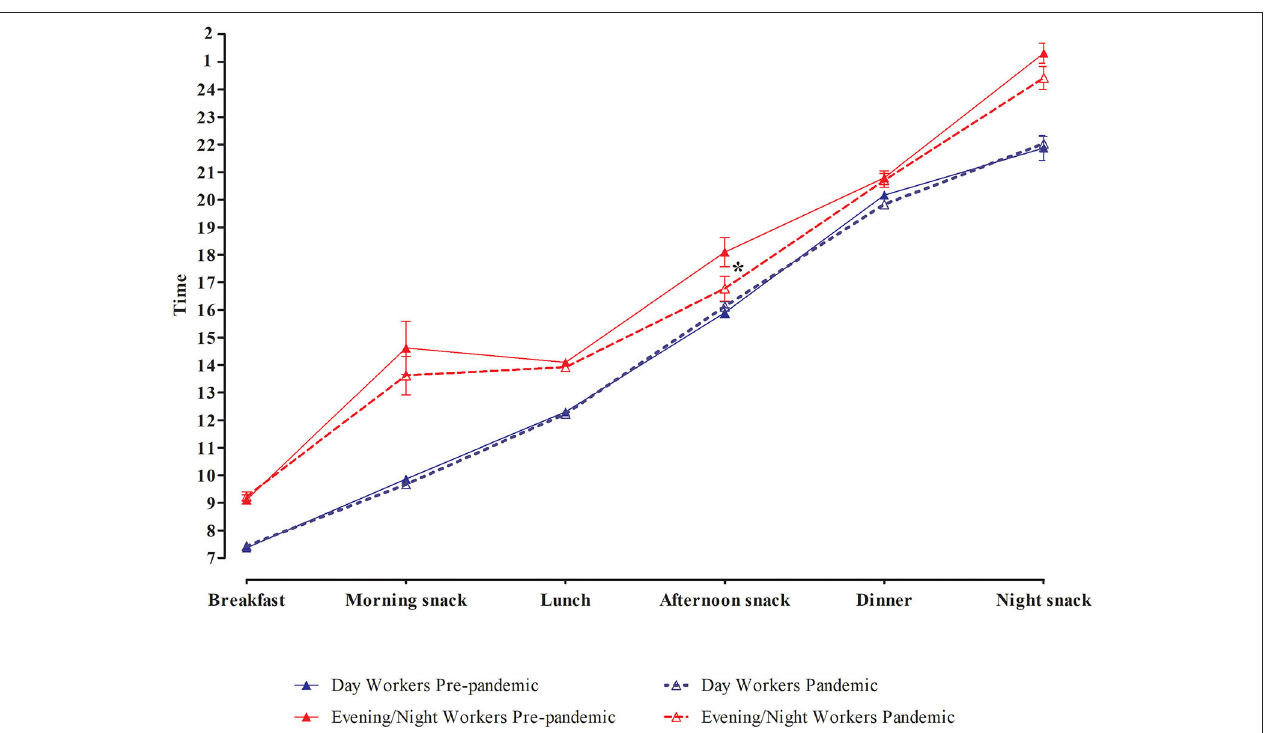
FIGURE 1 | Generalized linear model of meal timing in the pre-pandemic period and during the pandemic per work shift, adjusted for age and sex. Values are present as mean ± SE. More details in Supplementary Table 5